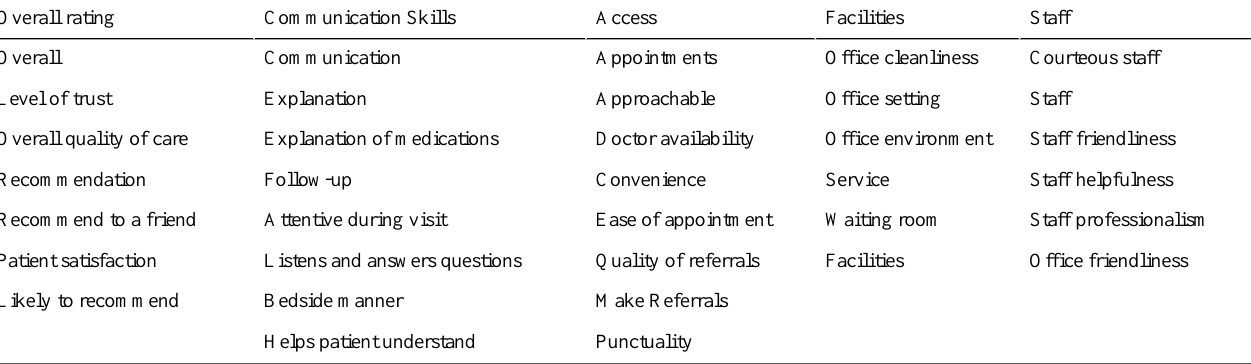
Table 1. Semantic conversion table used to normalize different dimensions of care used to rate physicians on the